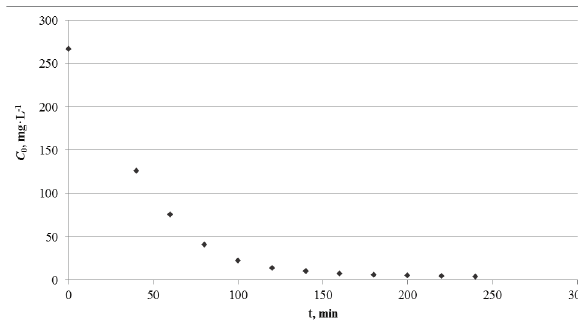
Figure 5: The changes in Cr(III) ions concentration in the solution during the biosorption